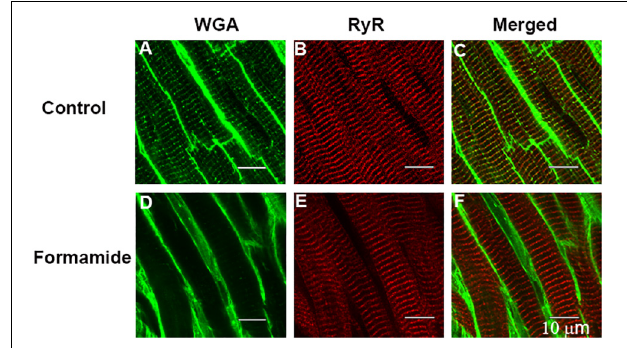
FIGURE 4 | Evidence of detubulation in response to formamide. Confocal images are shown of representative ventricular trabeculae labeled with t-tubule marker WGA (green) and anti-RyR antibody (red). Top row shows A : WGA, B : RyR, and C : merged labelling in a control trabecula. Bottom row shows D : WGA, E : RyR, and F : merged labelling in a formamide treated trabecula. Scale bar 10 µ